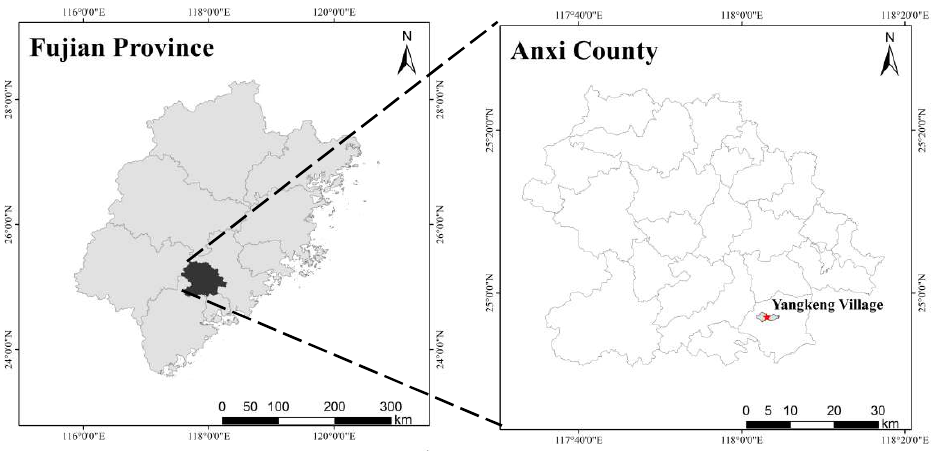
Figure 3. Location of the research site.